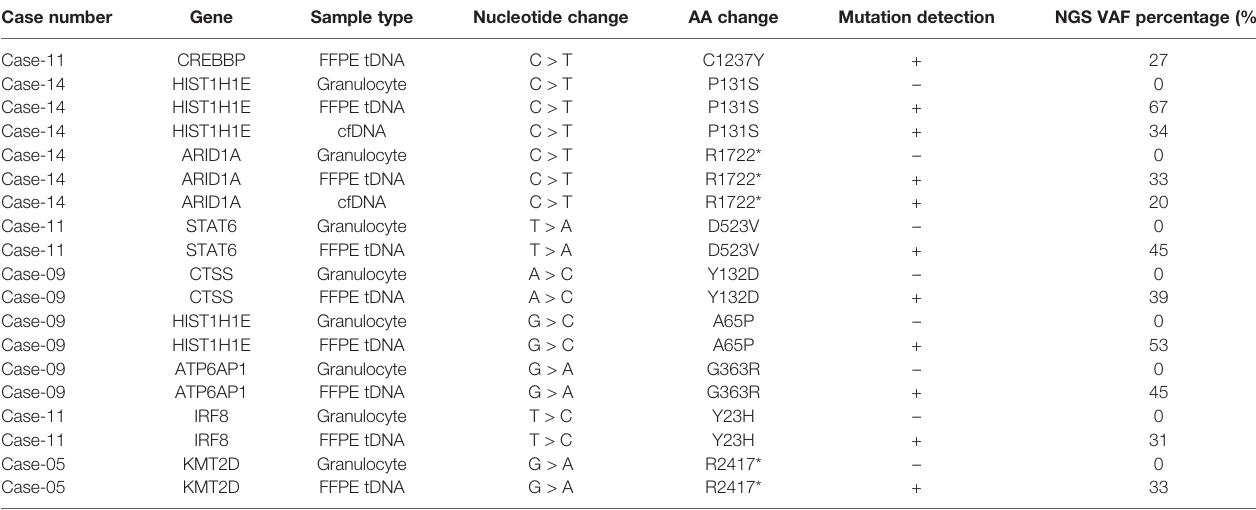
TABLE 4 | List of genes and variants cross-validated with PCR-Sanger sequencing and their con fi rmation